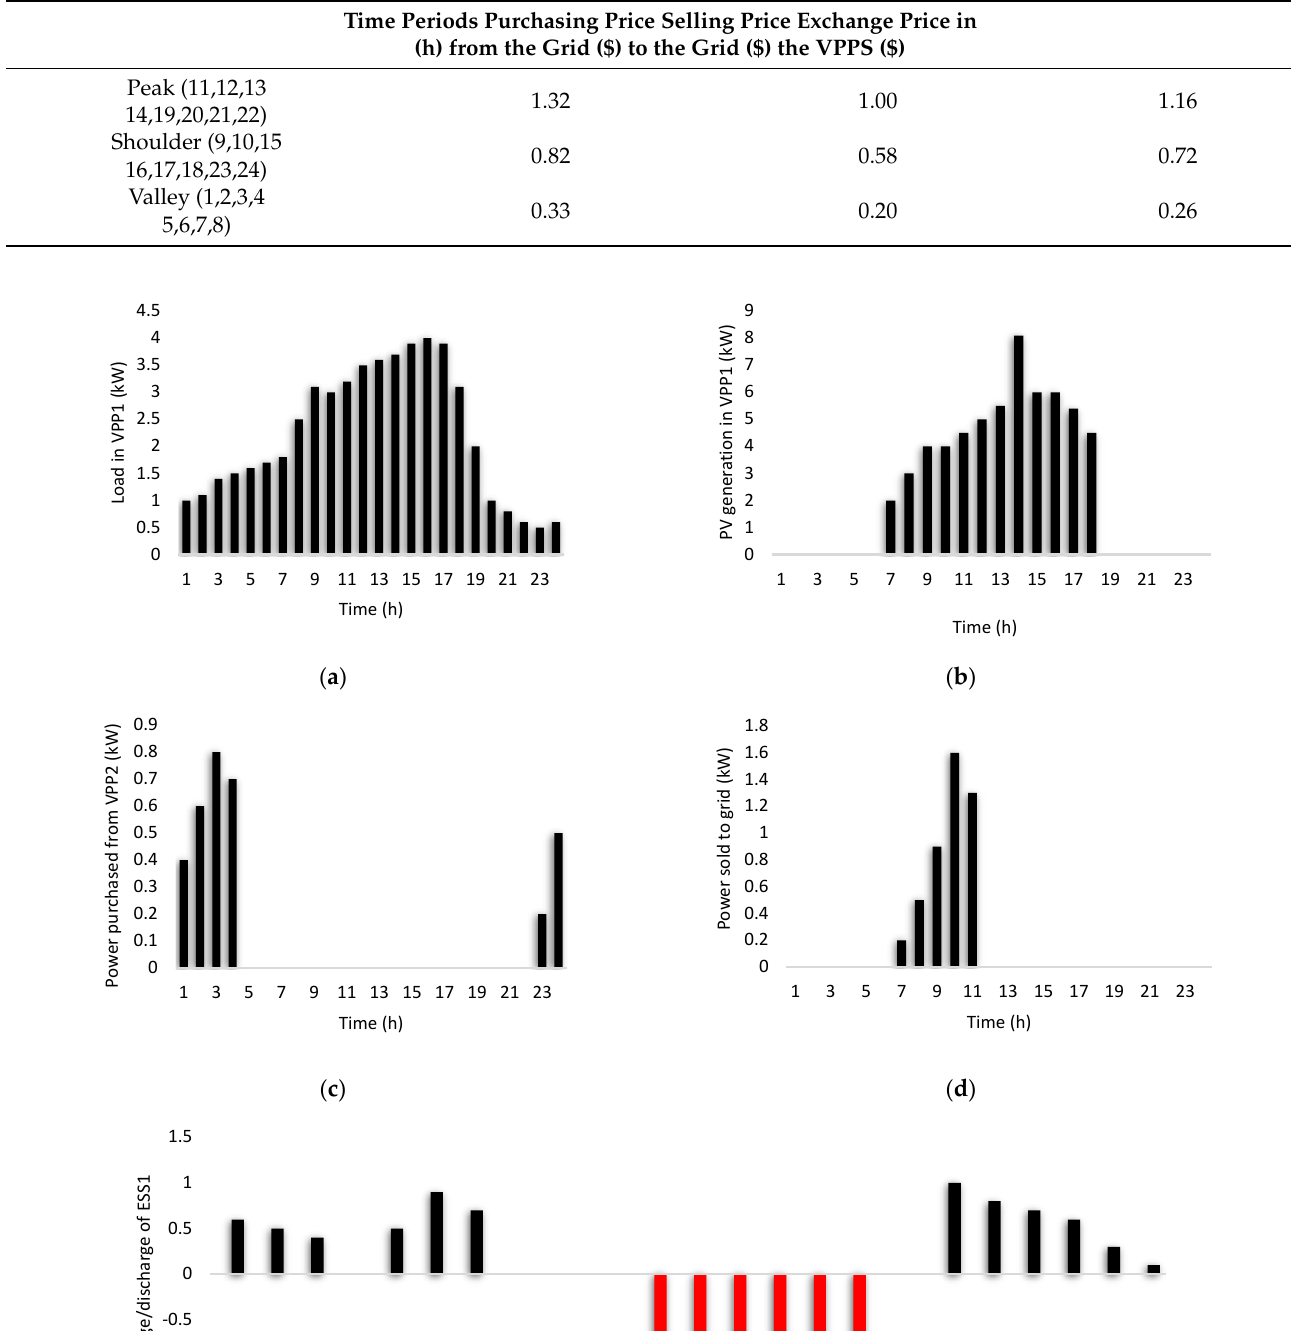
Table 3. Electricity tariffs (unit: $/kWh).